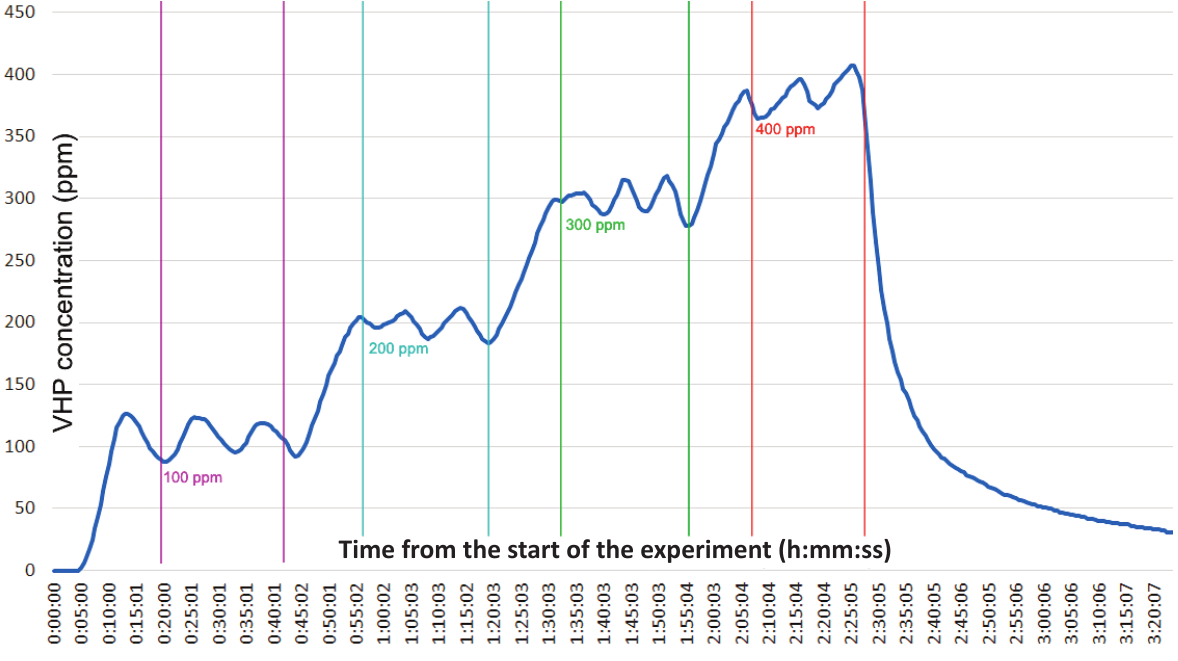
Time from the start of the experiment (h:mm:ss)